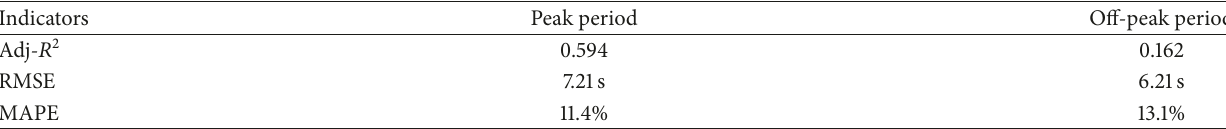
Table 6: Performance